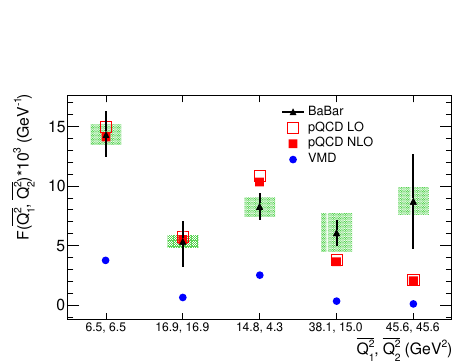
Figure 6. Comparison of the measured γ (cid:63) γ (cid:63) → η (cid:48) transition form factor (triangles, with error bars representing the statistical uncertainties) with the LO (open squares) and NLO (filled squares) pQCD predictions and the VDM predictions (cir-